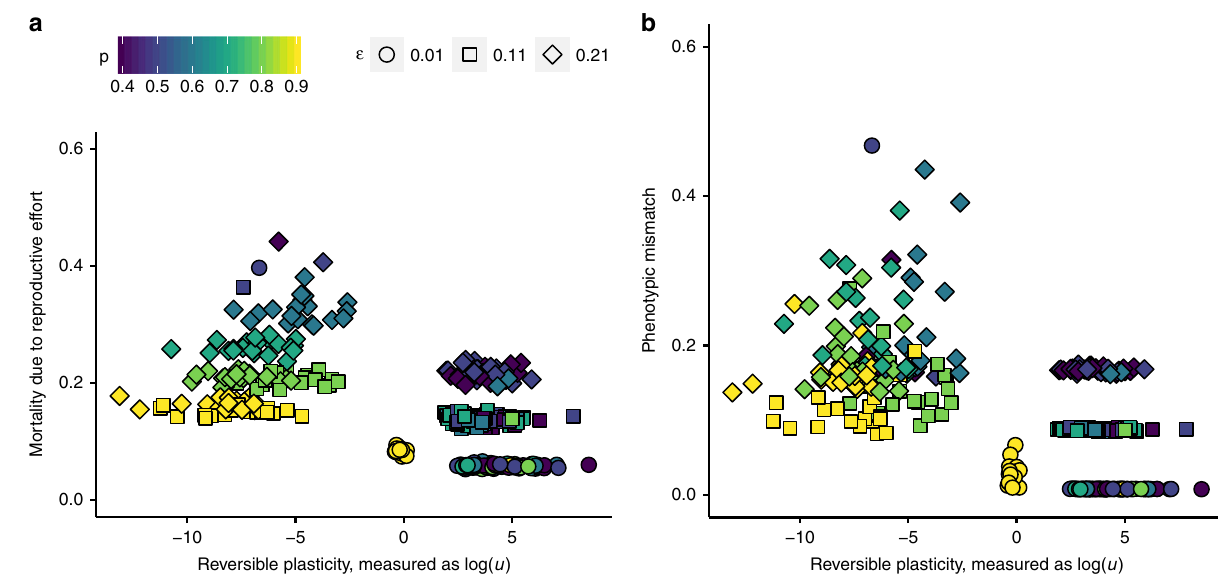
Fig. 3 Different sources of mortality. a Mortality due to mean reproductive effort in all populations measured at the end of the simulation ( t max ); there is a negative correlation because reproductive effort co-evolved to be negatively correlated to reversible plasticity (see Fig. 1b). b Mean population-wide mismatch against plasticity, measured as updating effort, u recorded at t max . Symbol shapes indicate updating error, ɛ ; colour (from dark blue to yellow) indicates increasing environmental autocorrelation ( p